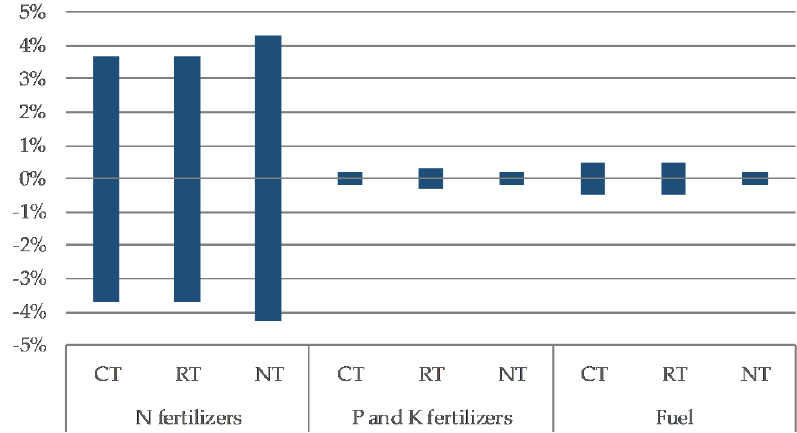
Figure 7. The sensitivity analysis of input parameters for the acidification potential of the winter wheat production in conventional tillage (CT), reduced tillage (RT), and no-tillage (NT).